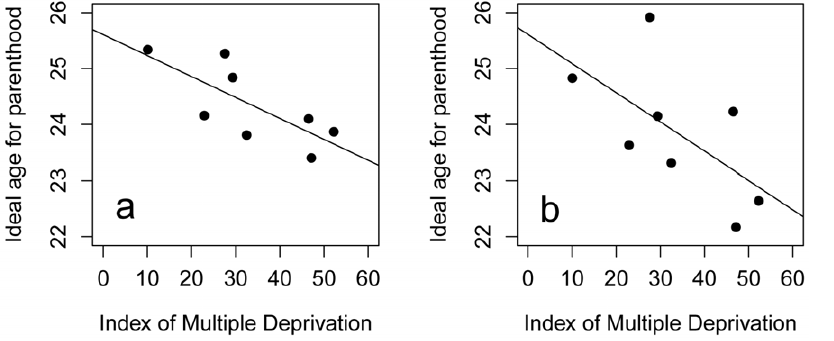
Figure 1. Marginal mean for each neighbourhood of ideal age for parenthood, adjusted for age group and sex, against the Index of Multiple Deprivation of that neighbourhood (a) for the whole sample, (b) for the 9–11 year olds only.